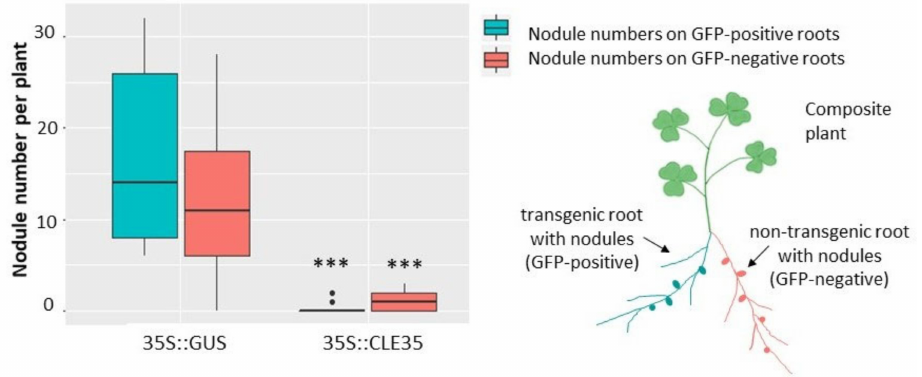
Figure 5. MtCLE35 overexpression systemically inhibits nodulation in wild-type plants. Nodule number in wild-type (A17) composite plants on green fluorescent protein (GFP)-positive transgenic roots (cyan) carrying the 35S :: GUS (control) or 35S :: MtCLE35 construct and on GFP-negative non-transgenic roots (coral) are represented. Box plots are presented with median values. Asterisks indicate statistically significant di ff erences (Mann-Whitney U test, p < 0.001).